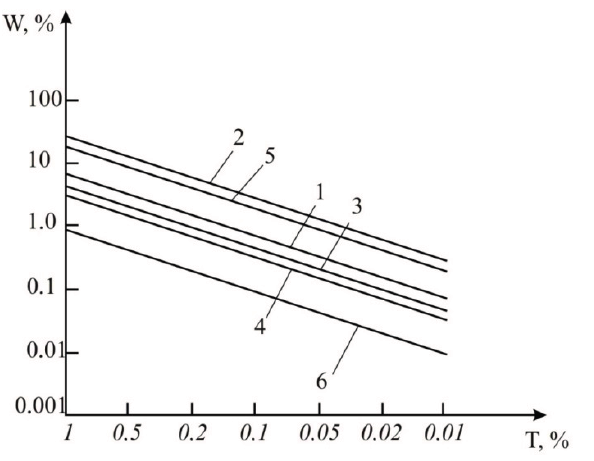
Figure 11. The results of computer modeling of TAF errors using biofuels for variants 1 -